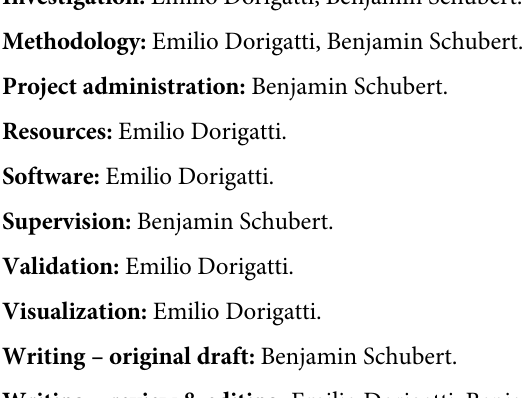
S1 Table. MHC alleles. This appendix contains a table listing the 27 MHC alleles used in this study and their percent frequency in the world